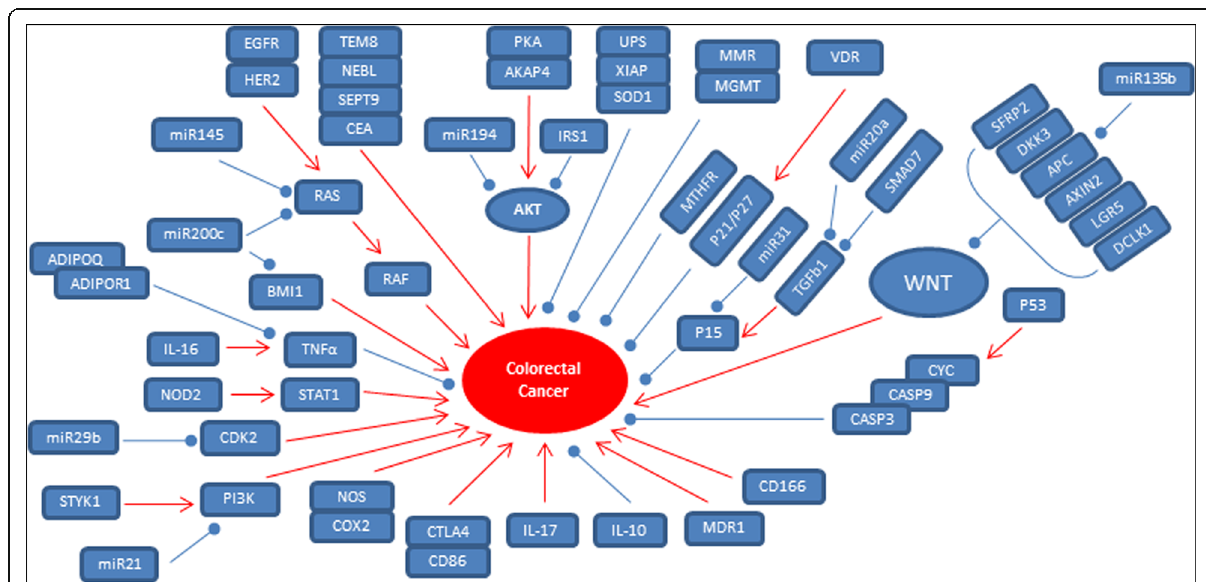
Fig. 1 all of the interactions and signaling pathways of reported markers which are involved in CRC progression among Iranian